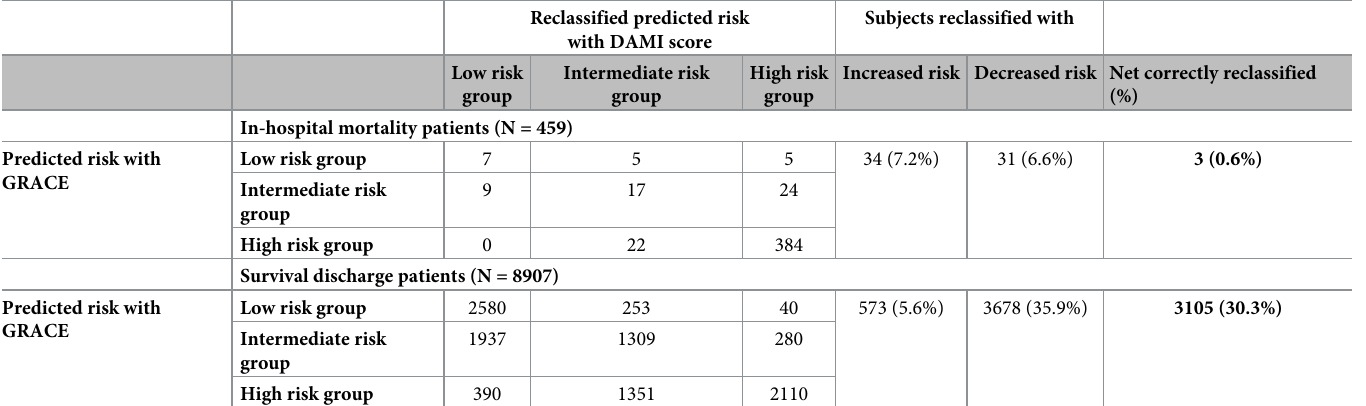
Table 2. Reclassification table.